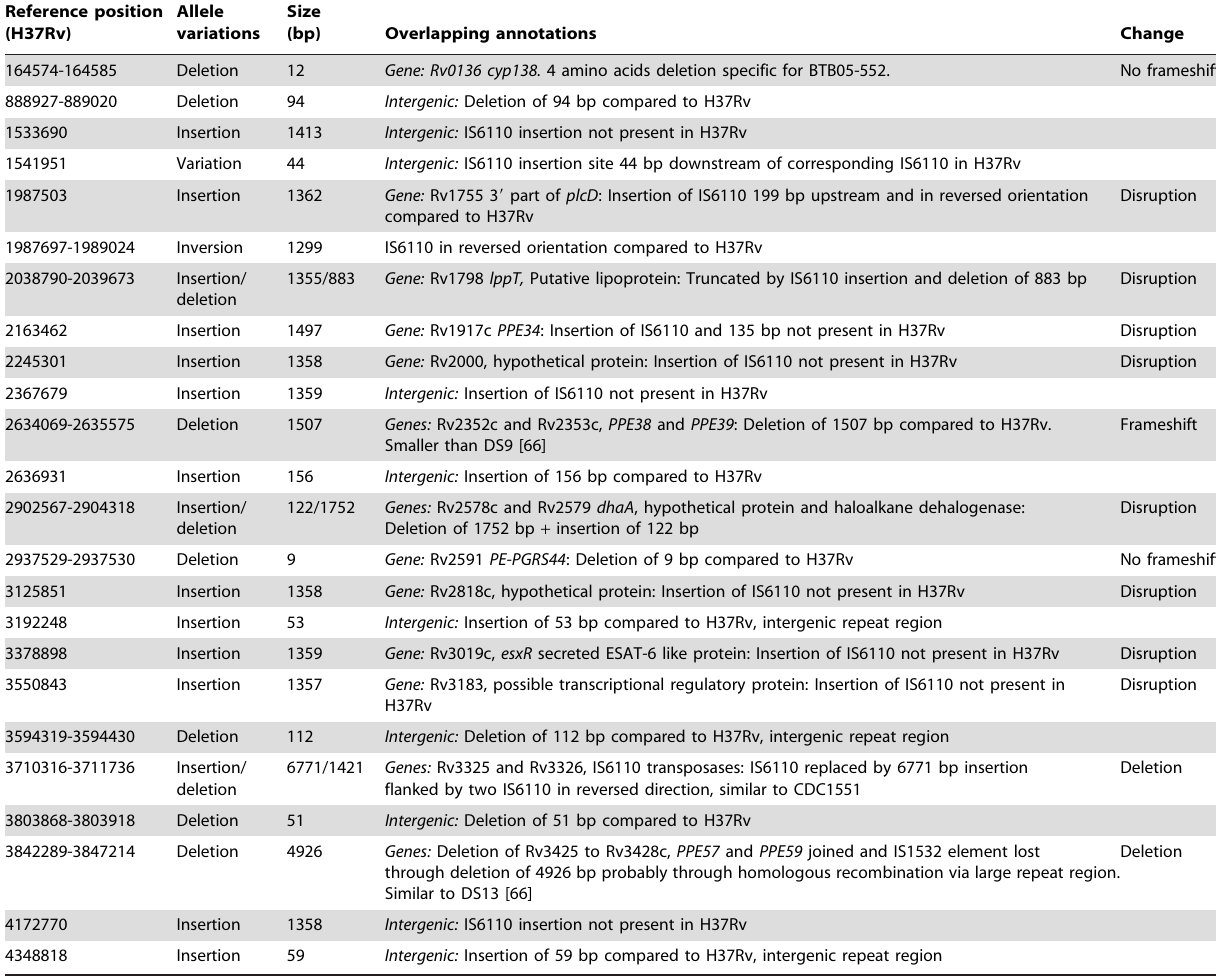
Table 1. SMI-049 specific large polymorphisms.